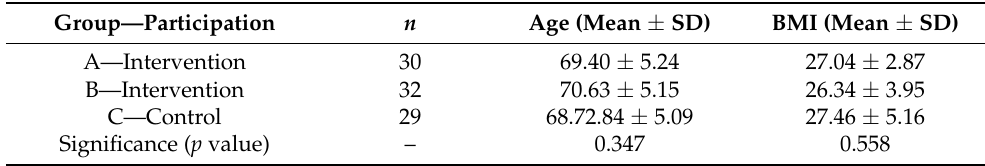
Table 1. Descriptive statistics for Group composition, age and